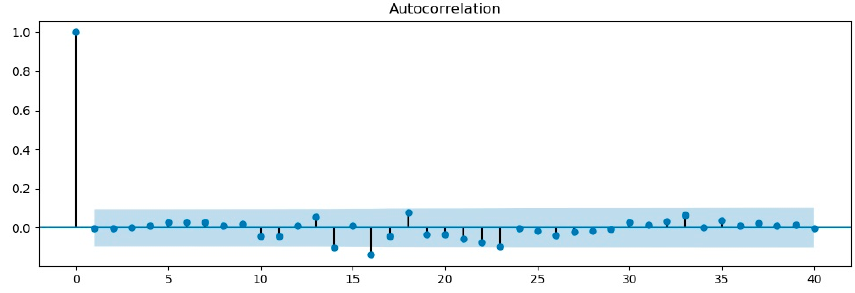
Figure 9. ACF diagram of the residual.